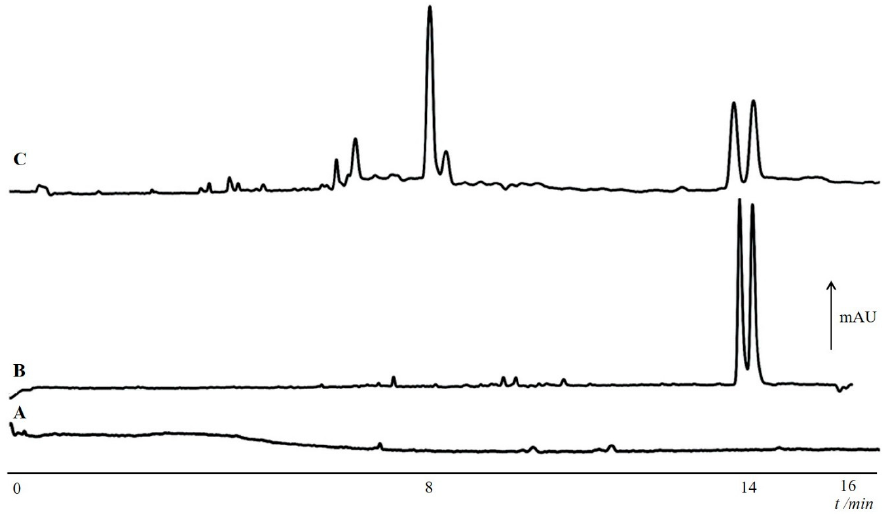
Figure 7. Sample electrochromatograms of ( A ) blank EBC, ( B ) an EBC spiked with 2.5 µ g/mL methadone and ( C ) EBC sample of a patient under MMT. Conditions: uncoated fused silica capillary, 50 cm (41.5 cm effective length) × 50 μ m i.d.; capillary temperature: 15 °C; sample injection: 40 s at 15 kV after preliminary pressure injection of water (1 s at 50 mbar); applied voltage: +25 kV; BGS: 150 mM phosphoric acid-TEA (pH 2.5) containing 30% methanol and 0.8% ( w / v ) carboxymethyl- β -CD. Reprinted with permission from [48] .